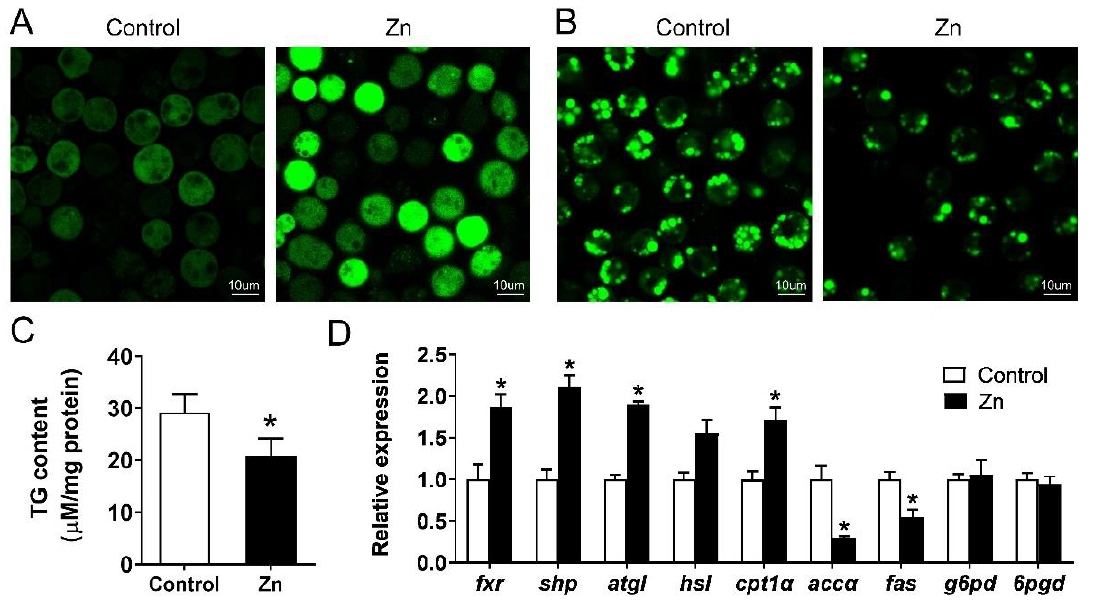
Figure 6. Effect of Zn incubation on cellular Zn concentration. ( A ): lipid droplet contents; ( B ): TG accumulation; ( C ): mRNA levels involved in lipid metabolism; ( D ): in hepatocytes of yellow catfish at 48 h. Results are presented as mean ± SEM ( n = 3). Asterisk (*) indicates significant differences in different treatments ( p < 0.05).